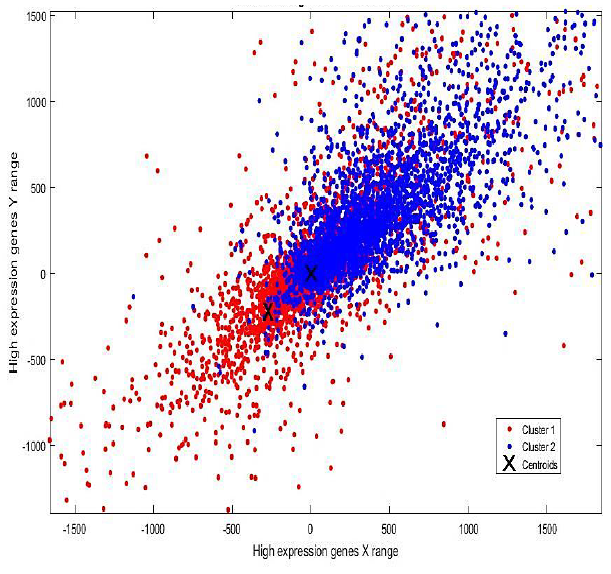
Figure 5. P-values for annotated terms in clustering In 72 samples and 7129 genes of gene expression data in